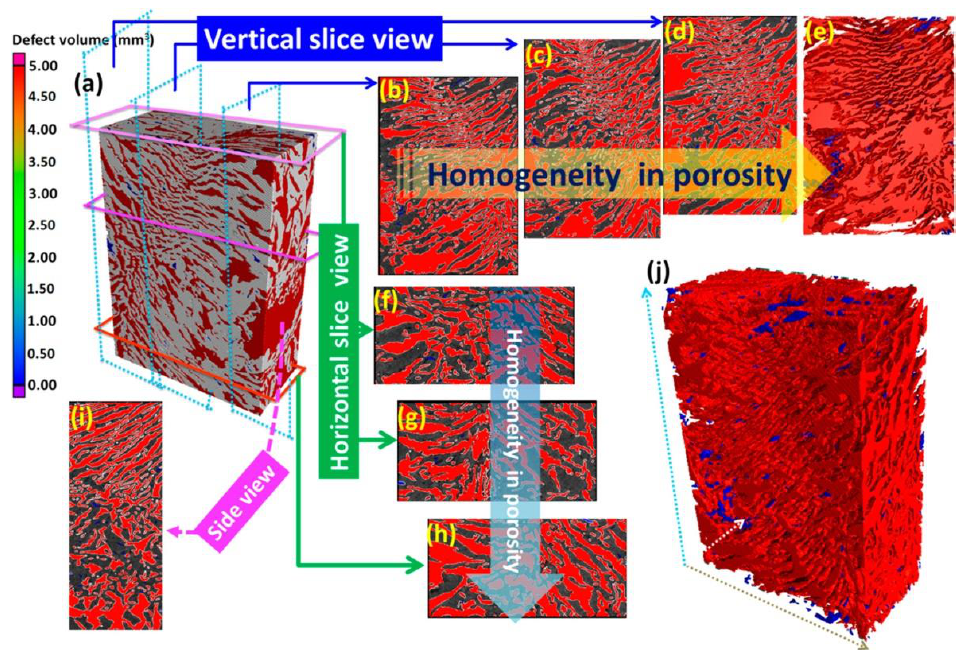
Figure 6. ( a ) 3D view of RGO –hydrogel monolith obtained by μ -CT. ( b – e ) Vertical slice view after reduction by software. ( f – h ) Horizontal slice view. ( i ) Side view. ( j ) 3D porous structure with connected (red portions) and nonconnected (blue domains) pores. Reproduced with the permission of [108] , Copyright 2018 American Chemical Society.